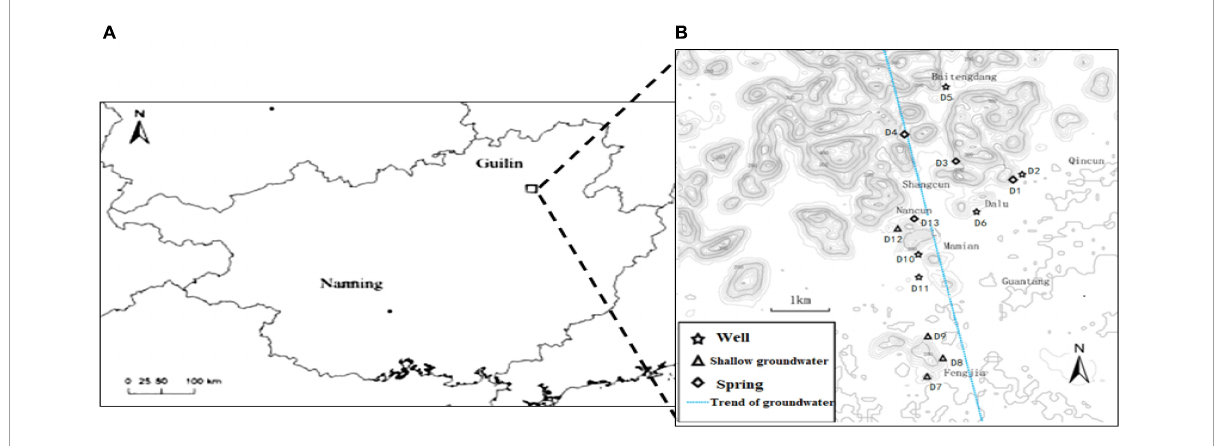
FIGURE1 Schematic diagram of the study area and sampling sites in the Huixian karst groundwaters. (A) Location of the Huixian karst wetland; (B) Location of the sampling sites in the Huixian karst groundwaters.